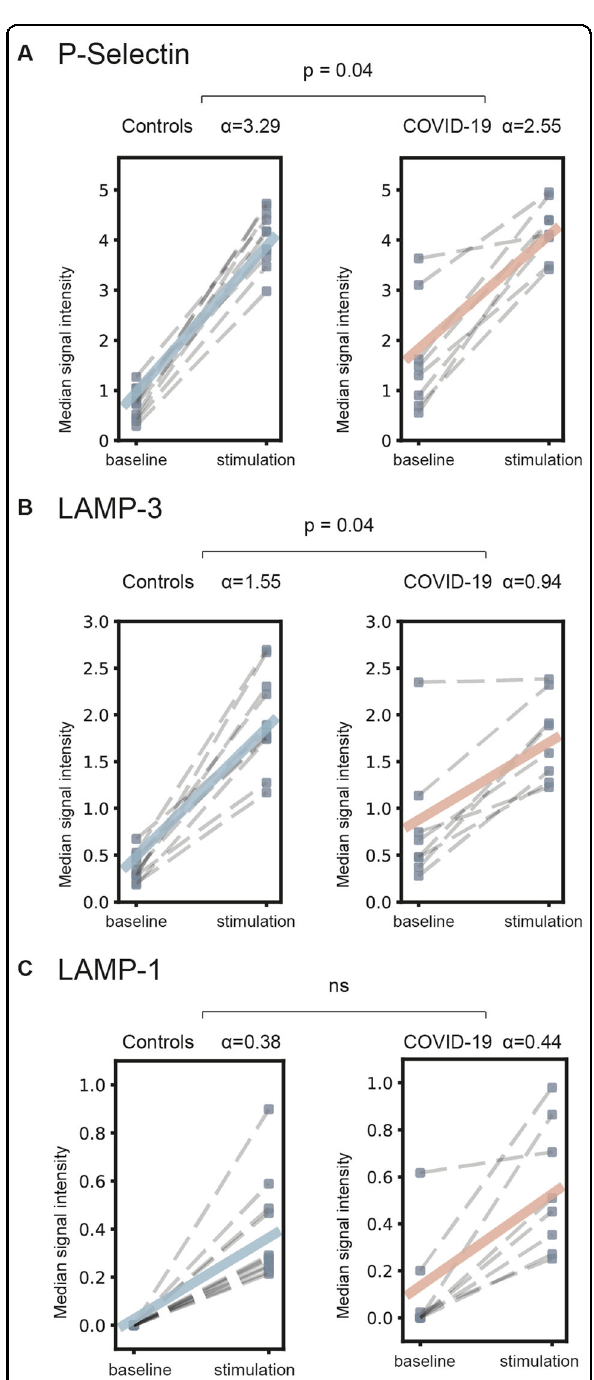
Fig. 4 Platelet reaction capacity. Median signal intensity increase of activation marker expression after TRAP stimulation (10 µM) compared to non-stimulated platelets (baseline). Linear model analysis detected a reduced capacity of COVID-19 patients to increase expression of activation markers LAMP-3 and P-Selectin ( p = 0.04 and p = 0.04) after TRAP stimulation. A P-Selectin, B LAMP-3, C LAMP-1. α : signal increment slope coef fi cient (for details see Methods); ns: nonsigni fi cant. N = 8 COVID-19 patients, 11 healthy